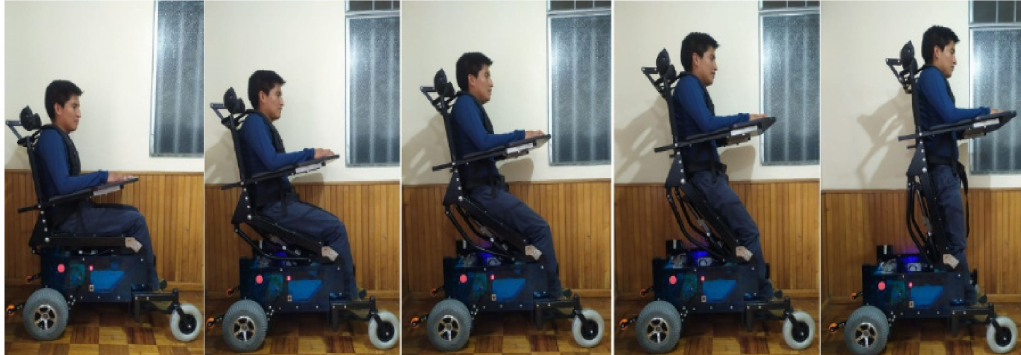
Figure 11. Autonomous movement of the standing human–wheelchair system.